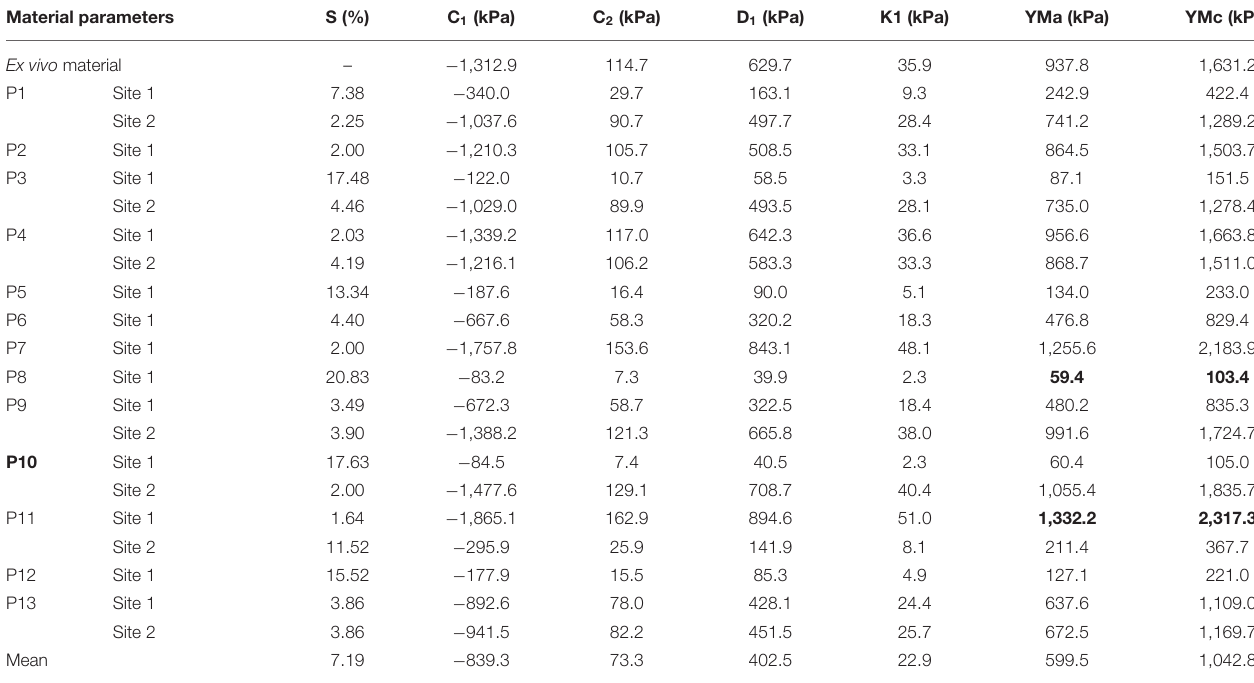
TABLE 2 | Values of material parameters, circumferential shrinkage rates, and Young’s modulus (YM) in both directions of the 20 slices. Material